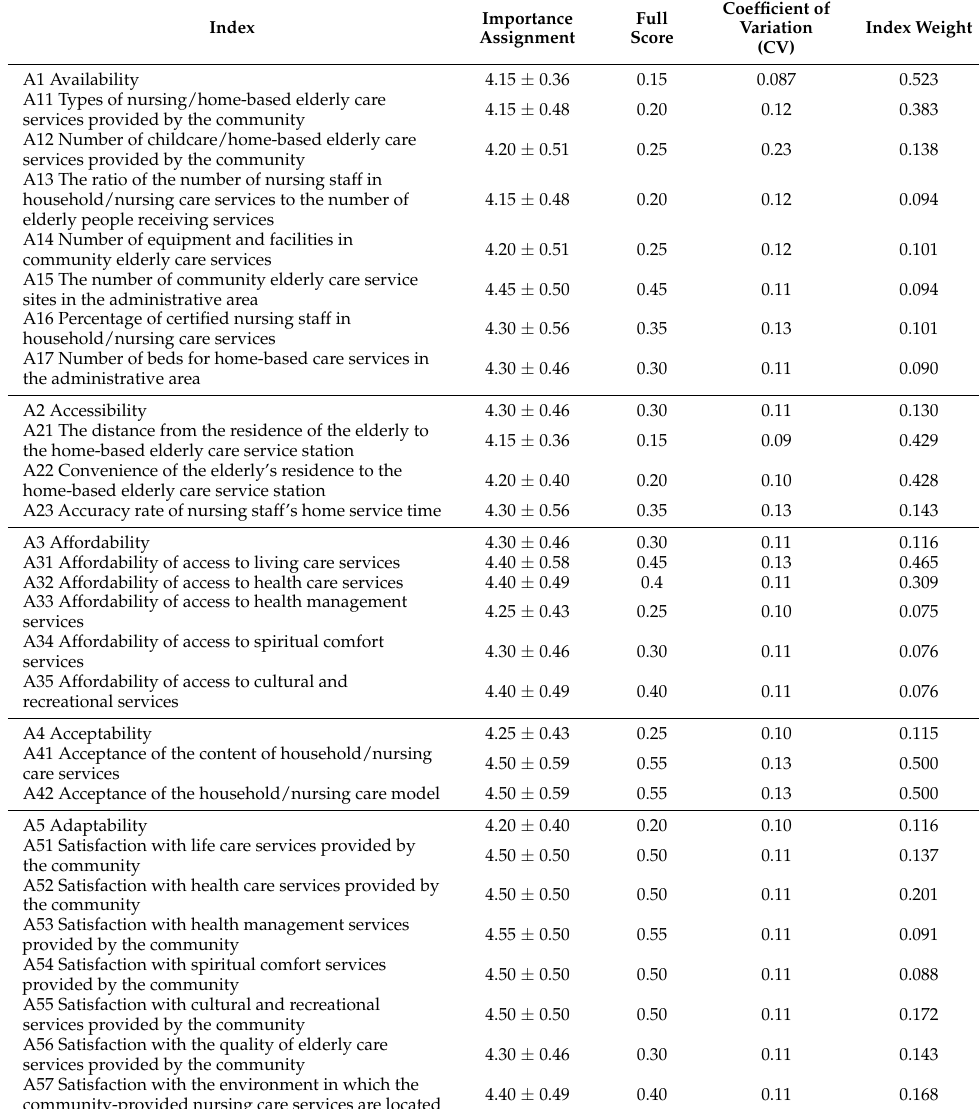
Table 6. Availability of home-based and community-based elderly care